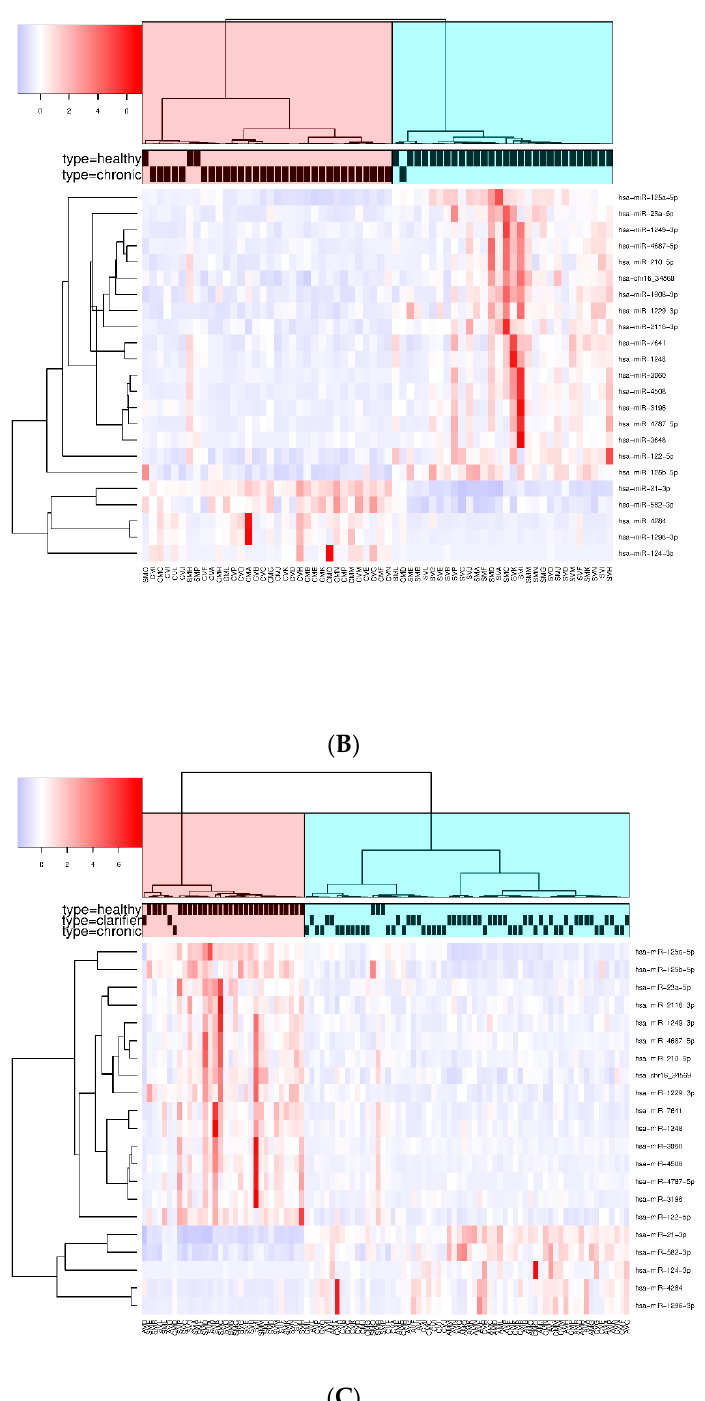
Figure 3. Heatmap and unsupervised clustering of SDE miRNAs compared between groups of study. Only miRNAs common to the three methods of analysis are shown. Columns represent each sample, while rows correspond to SDE miRNAs between groups of comparison. The miRNA clustering tree is shown on the left, and the sample clustering tree is shown at the top. The color scale at the top left illustrates the relative expression level of SDE miRNAs, with red indicating a higher expression level and blue a lower expression level. ( A ) HC versus SC; ( B ) HC vs. CHC patients; and ( C ) SDE common to SC vs. HC and CHC vs. HC.